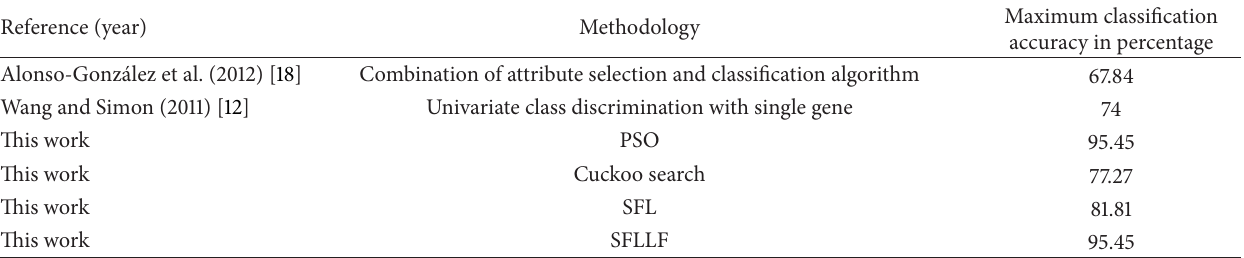
Table 6: Comparison of classification accuracy with other methods for DLBCL Outcome.